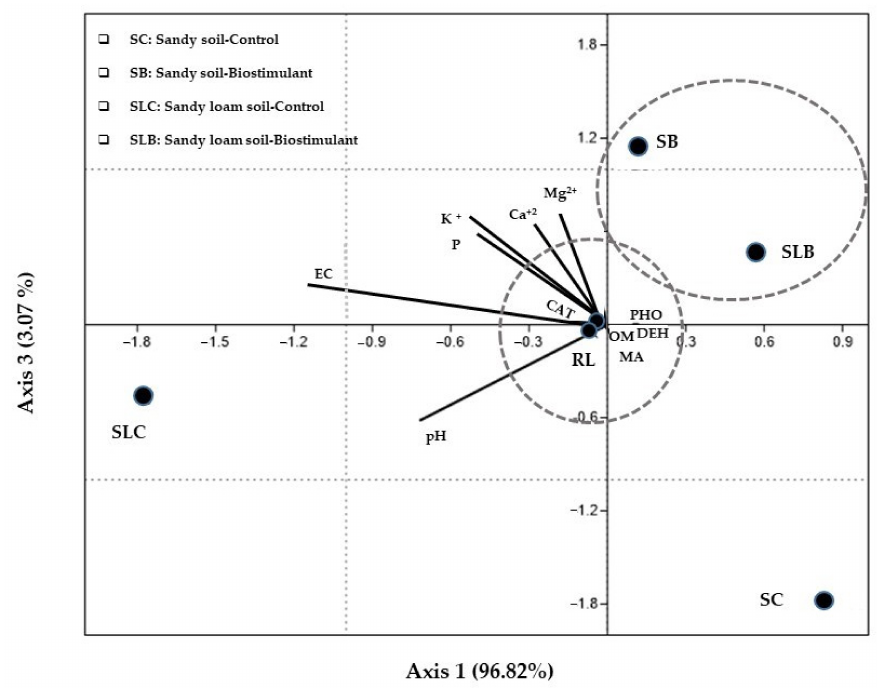
Figure 4. Canonical analysis using, as a variable, all parameters measured for the two types of soil. CAT, Catalase; PHO, Phosphatase; DEH, Dehydrogenase; MA; Microbial activity; OM, Organic matter; RL, Root